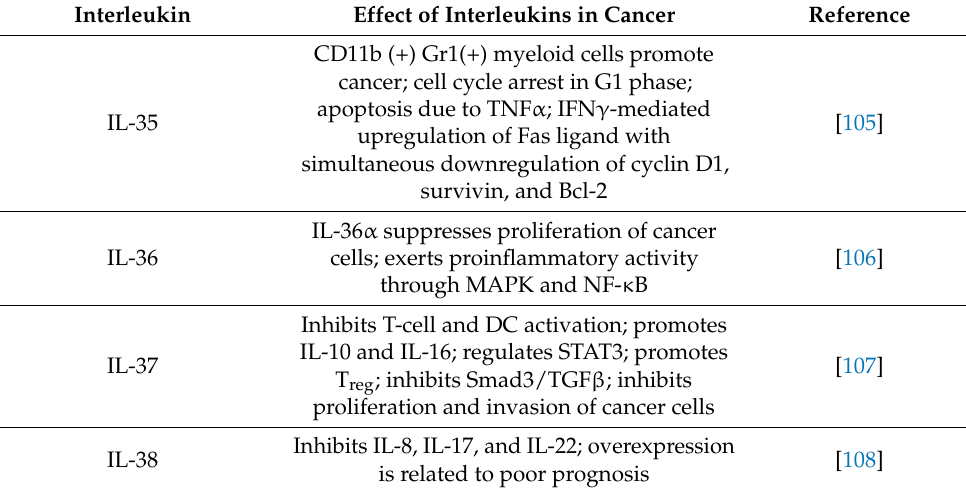
Table 2. Cont. Interleukin Effect of Interleukins in Cancer